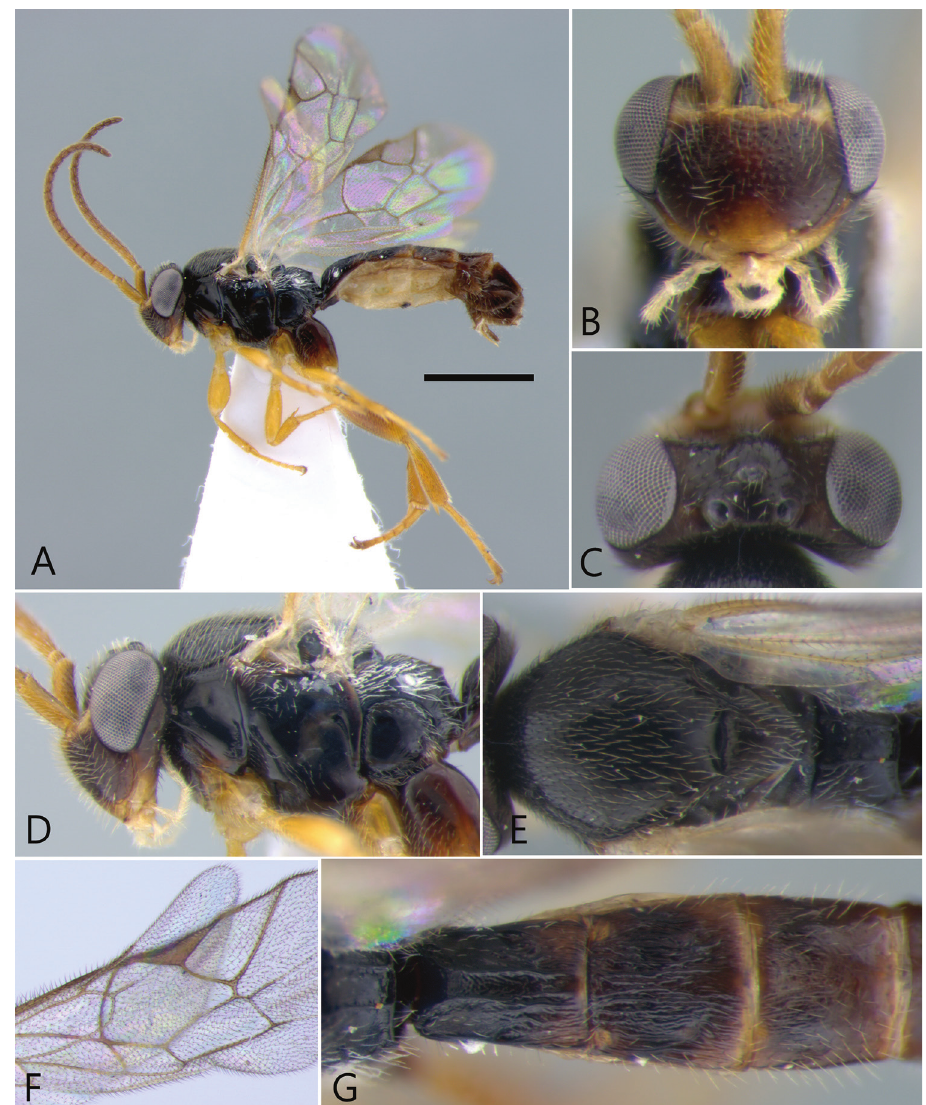
Figure 8. Orthocentrus leei sp. nov. Holotype. A Habitus in lateral view B head in frontal view C head in dorsal view D head and mesosoma in lateral view E mesosoma in dorsal view F areolet G first to third tergites in dorsal